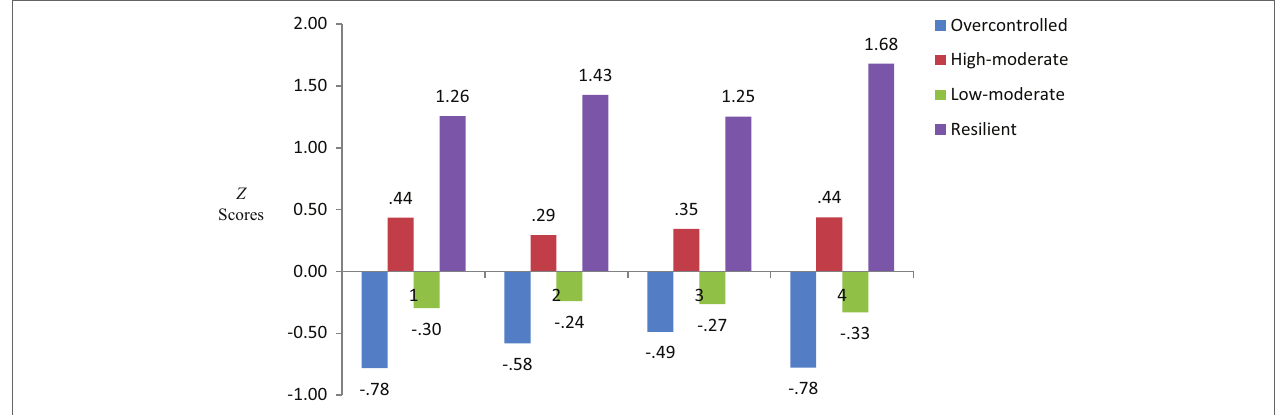
-1-0.500.511.5 FIGURE 3 | A simple slope plot of the moderating effect ( n = 1,075). Note: 1, overcontrolled group, 2, high-moderate group, 3, low-moderate group, 4 = resilient